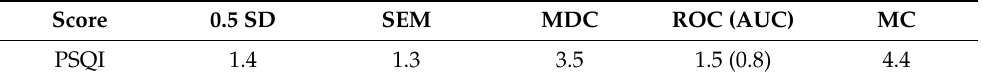
Figure 1. Receiver operating characteristic curve (ROC) for the prediction of PSQI’s minimum clinically important difference (MCID) based on the question “How do you feel after the surgery performed?”. Table 1. MCID for PSQI calculated by both distribution-based and anchor approaches 1